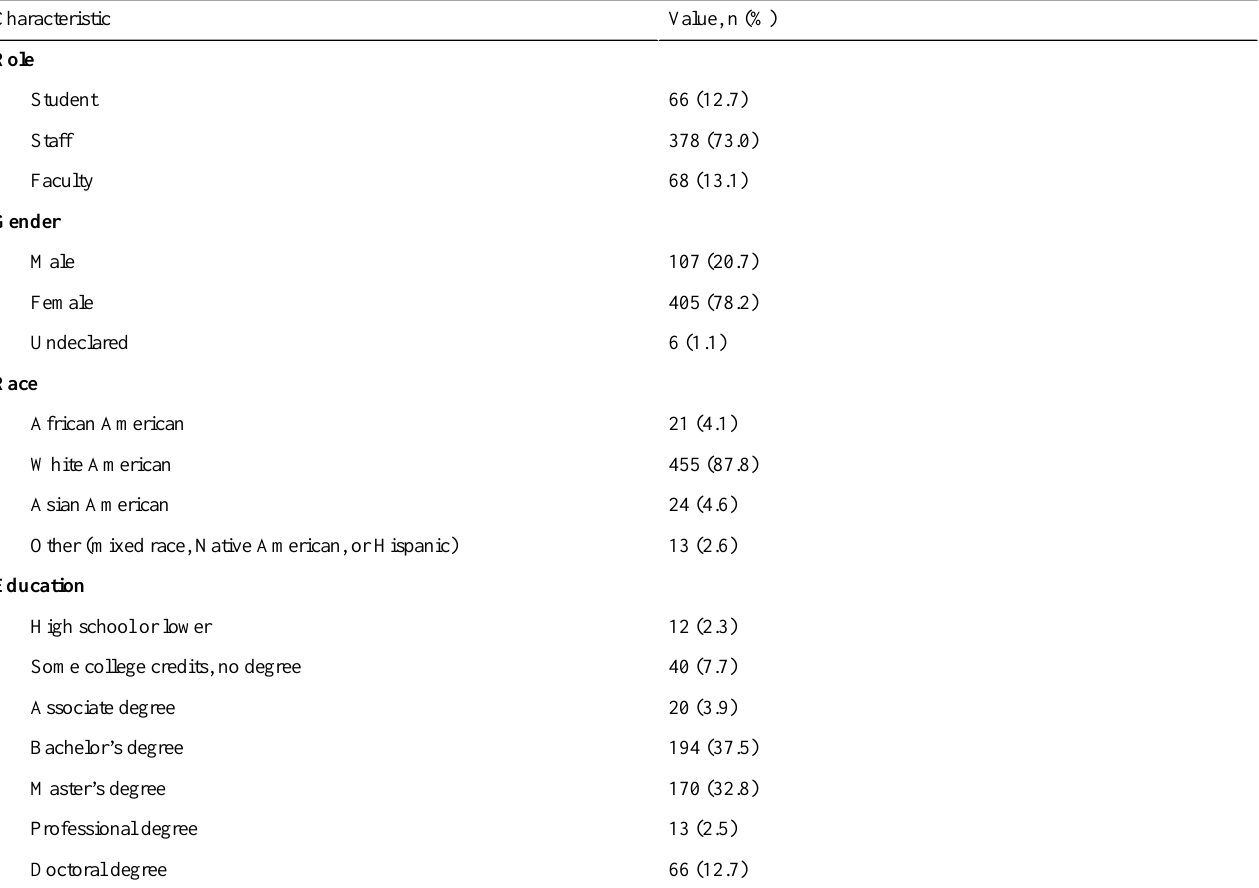
Table 1. Demographic information of the 518 study participants in the first questionnaire